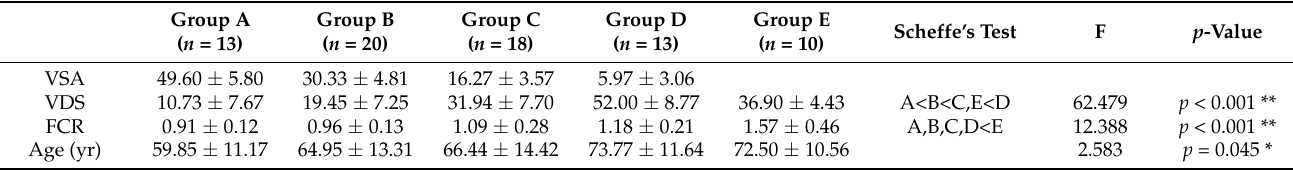
Table 4. Patient characteristics based on the VSA.